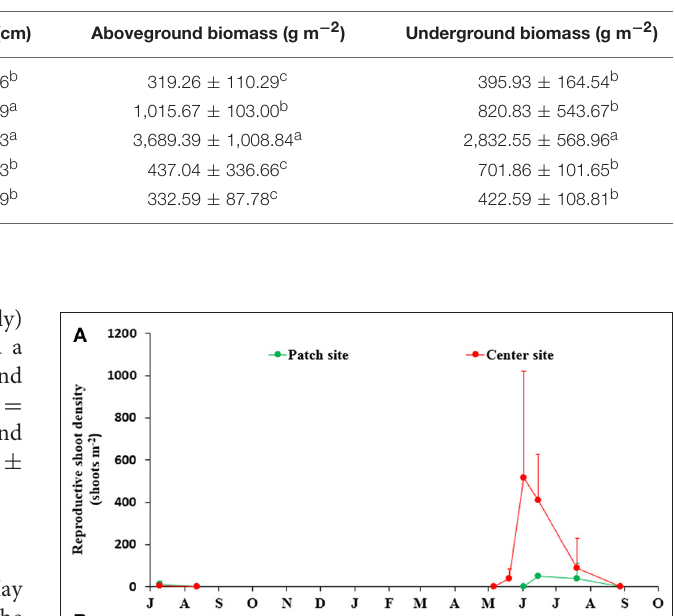
TABLE 1 | The shoot density, shoot height, and aboveground and underground biomasses of Zostera marina in Huiquan Bay.